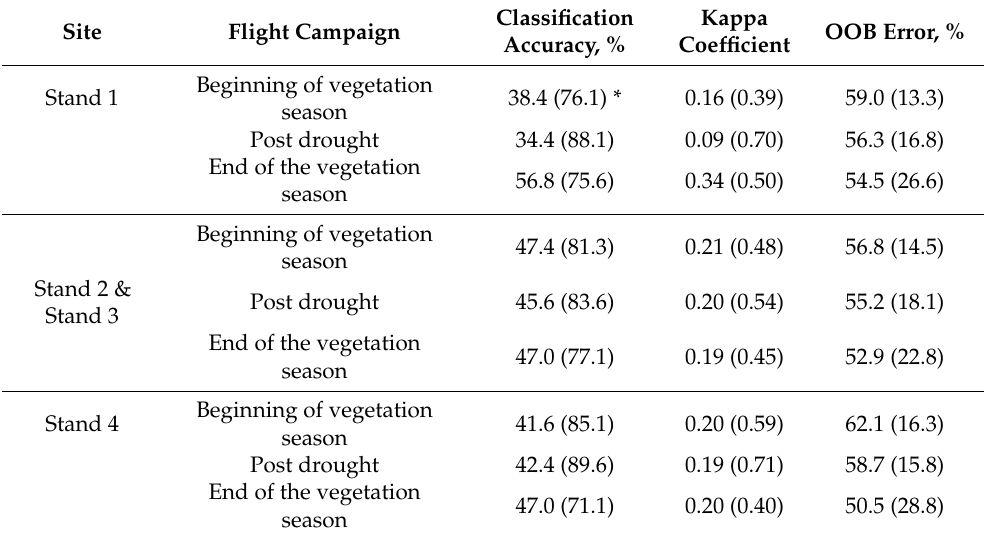
Table 6. The calculated classification accuracy of Random Forest classifier and OOB error grouped by six tree health classes. * the OOB error for two tree health classes is shown in brackets; Kappa coefficient interpretation: 0.00–0.20 as weak, 0.21–0.40 as fair, 0.41–0.60 as moderate, 0.61–0.80 as substantial, 0.81–1.00 as almost perfect.